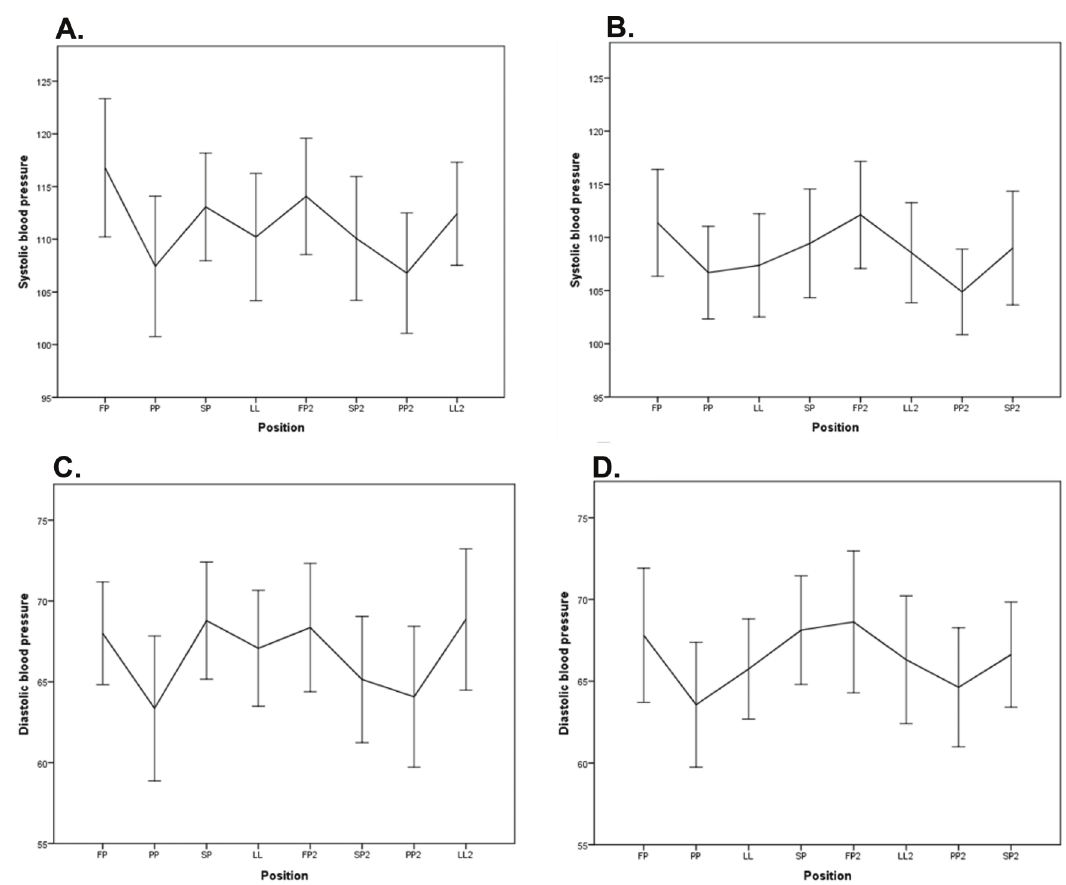
Figure 5 - Graphical representation of the systolic blood pressure of the pregnant women who performed sequence 1 (A) and sequence 2 (B). Graphical representation of the diastolic blood pressure of the pregnant women who performed sequence 1 (C) and sequence 2 (D).